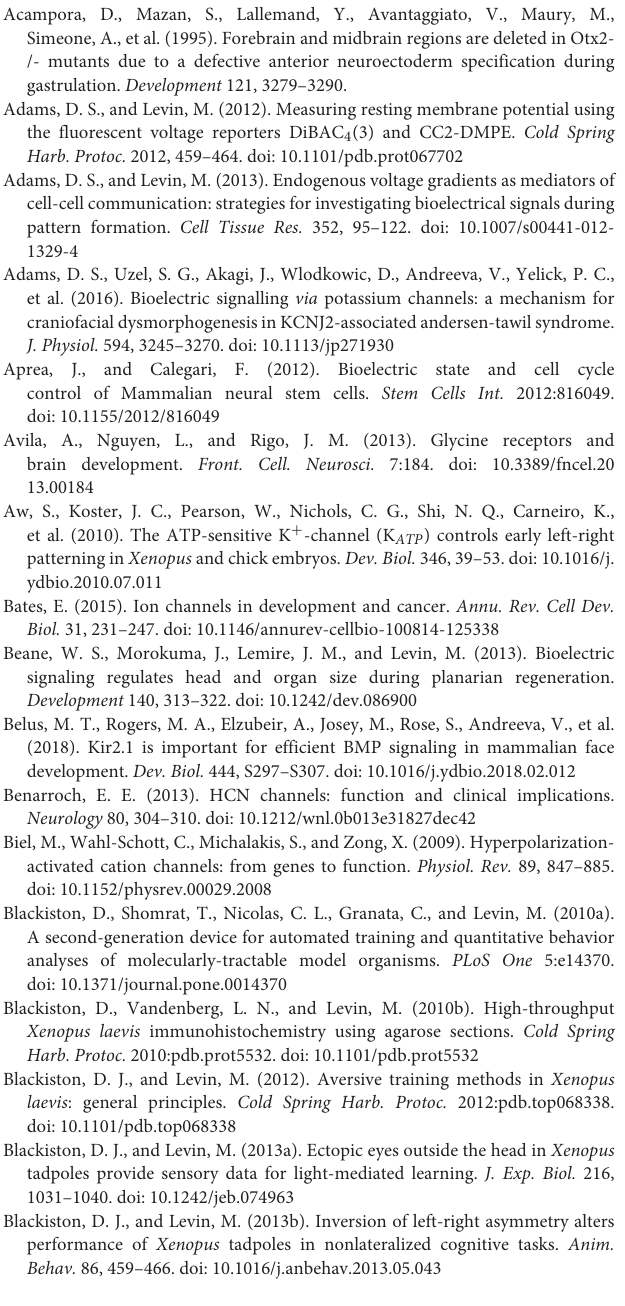
function usually employed to fit the experimental distribution of conductances and the residual conductance and G res (Spray et al., 1981; Cervera et al., 2018). The cases V 0 = 18 mV and G res = 0 (A) and V 0 = 12 mV and G res = 0.05 G o (C) are shown. The current-voltage curves of the junction [ right , (B,D) ] are obtained as the product I = G ij ( V i − V j ). These curves usually show a non-zero residual conductance [ right , (D) ] in the experimental range studied (Spray et al., 1981; Cervera et al., 2018). TABLE S1 | Distribution of various phenotypes in nicotine-exposed